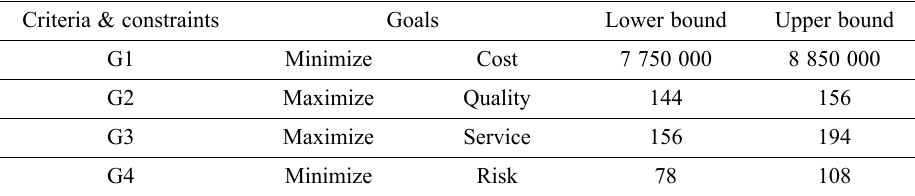
Table 13. Goals for supplier selection